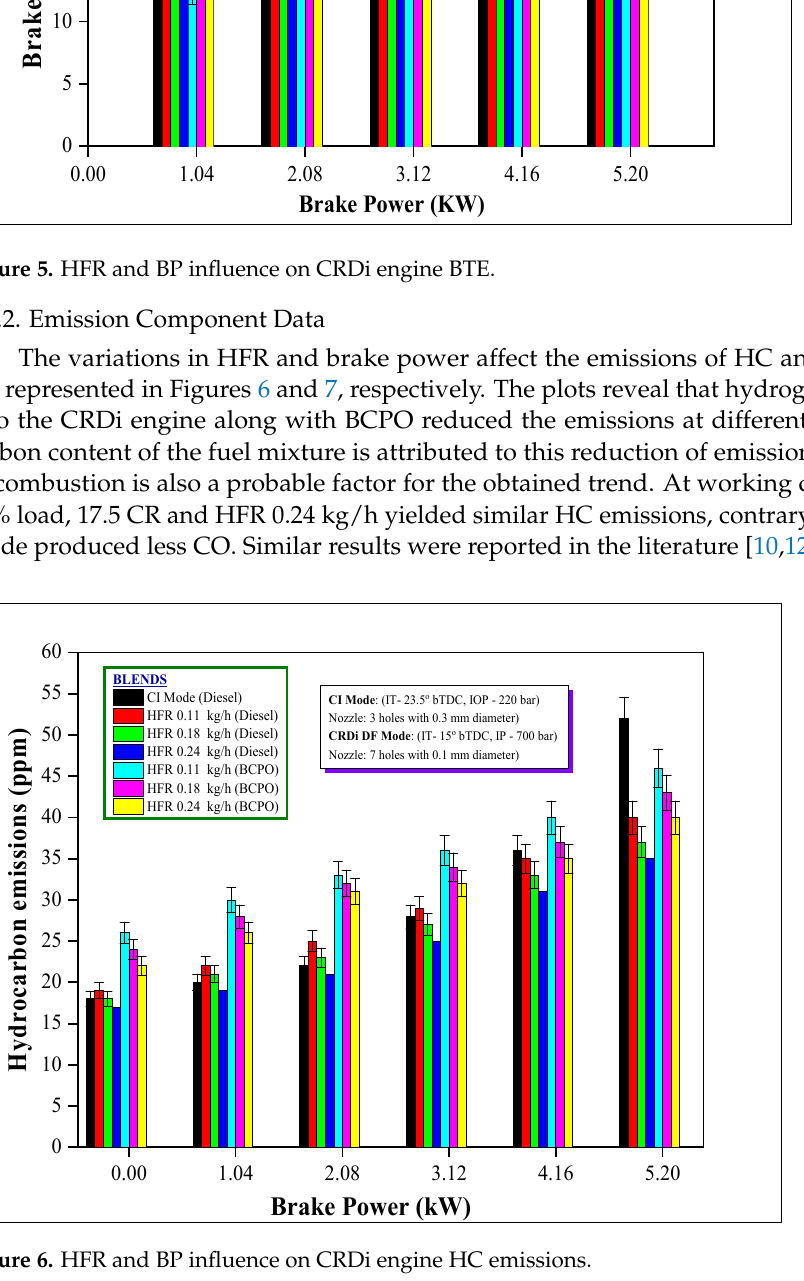
Brake Power (kW) Figure 7. HFR and BP influence on CRDi engine CO emissions. The HFR and BP influence on emissions of NOx in the CRDi engine is shown in Fig ‐ ure 8. At all loads, NOx emission increased at higher HFR. The likely reason could be